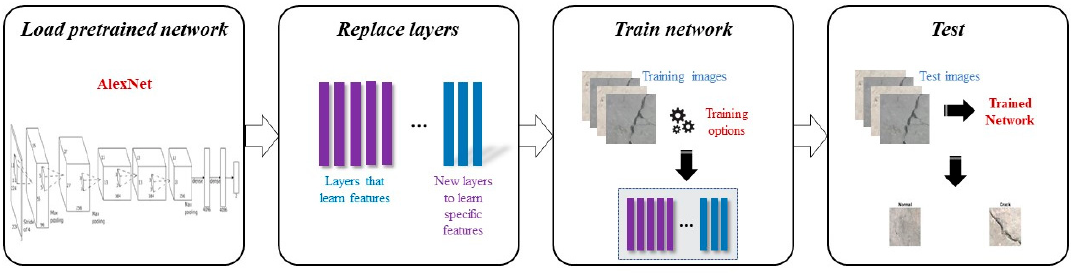
Figure 2. AlexNet CNN